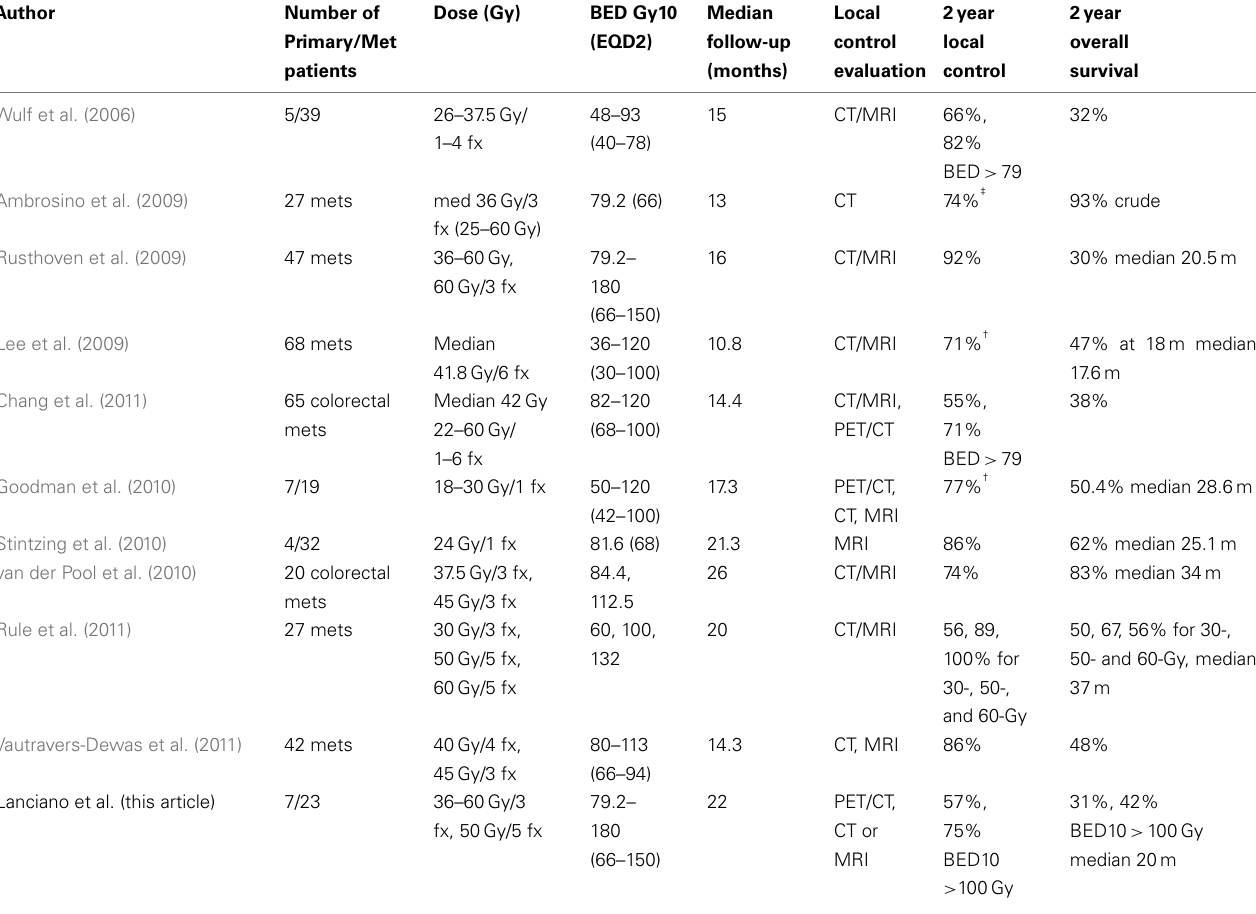
Table 3 | Review of stereotactic body radiation therapy for liver metastases and liver